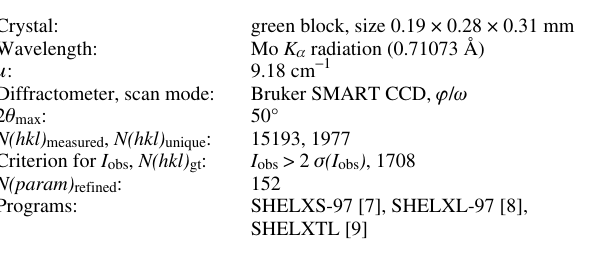
Table 1. Data collection and